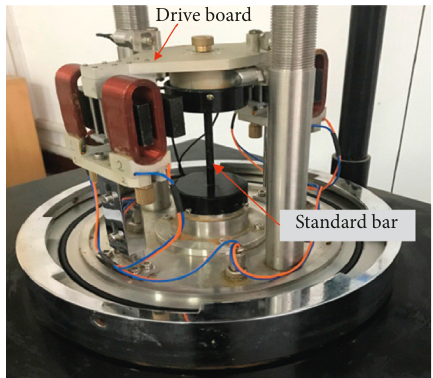
Figure 5: Photo of installed standard bar.